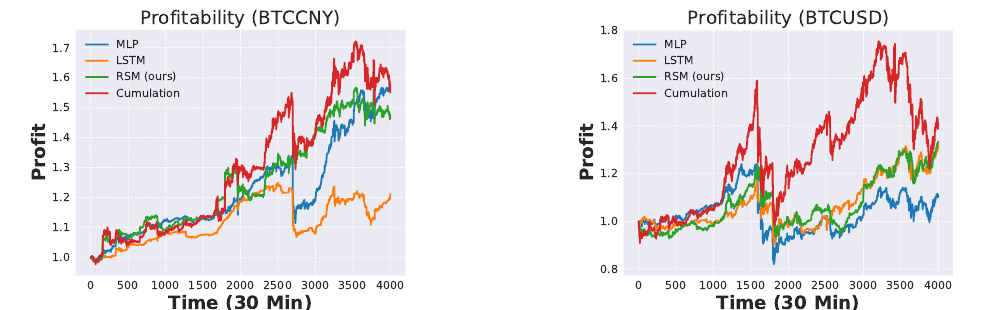
Figure 9. Visualization for profitability of BTCCNY ( left ) and BTCUSD ( right ) at each time step. Cumulation on each graph denotes the exponential of the cumulative log return value at that time step. Refer to Figures 3 and 4 for price.